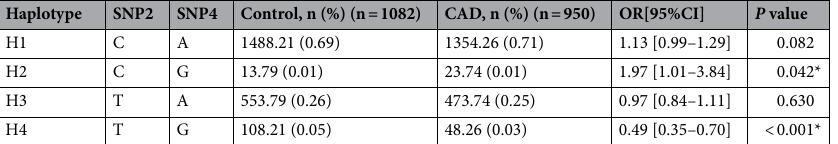
Table 5. Haplotype analysis in patients with CAD and control subjects. SNP2: rs2483205; SNP4: rs562556. *: p < 0.05.